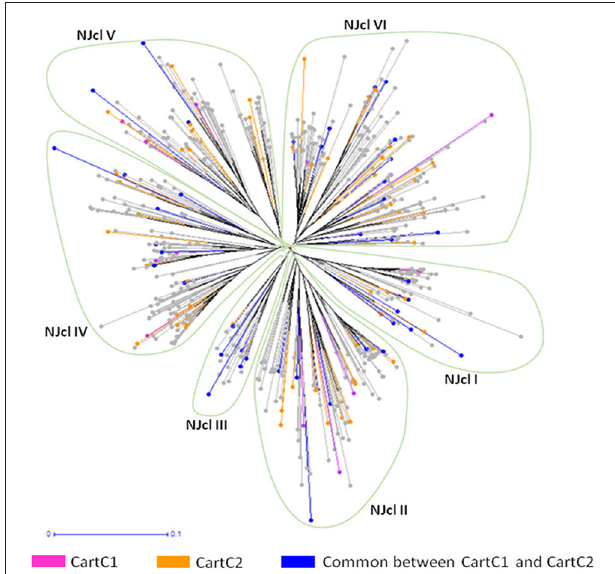
FIGURE 4 | Distribution of accessions of composite core collections (CartC1 and CartC2) in different clusters of Neighbor joining dendrogram (molecular data). Six clusters (NJcl I–VI) are shown. Accessions unique to CartC1 and CartC2 are represented by pink and orange color, respectively. Accessions common between these two collections are represented by